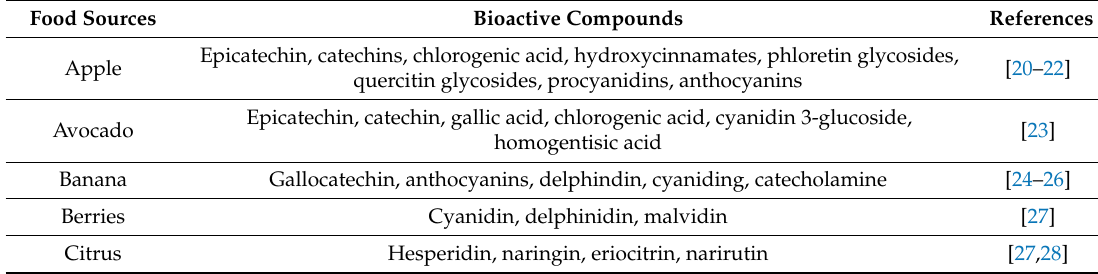
Table 1. Bioactive compounds in different food